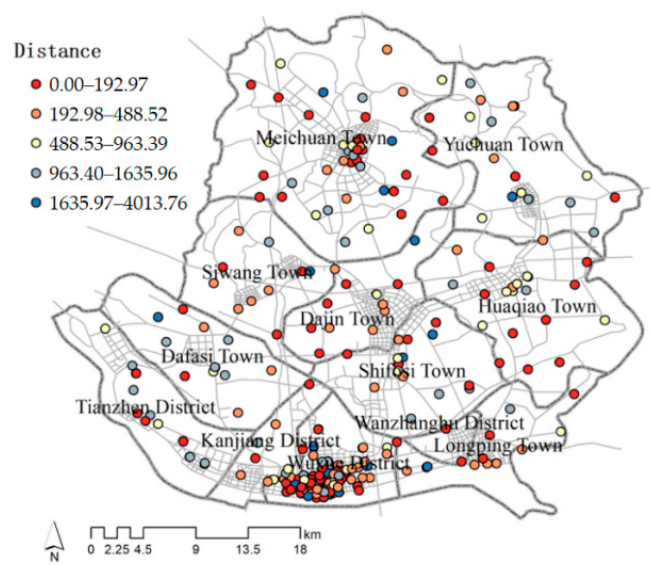
Figure 22. Accessibility analysis based on travel distance after modification.